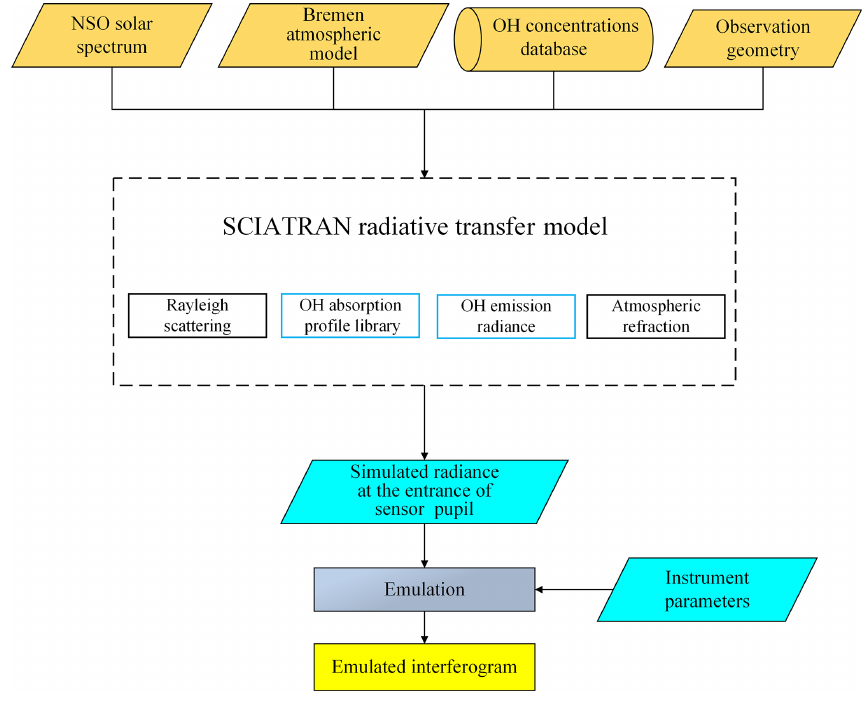
Figure 6. Flowchart of the forward model. Table 1. The intensity of simulated observation radiance and atmospheric background radiance at some tangent